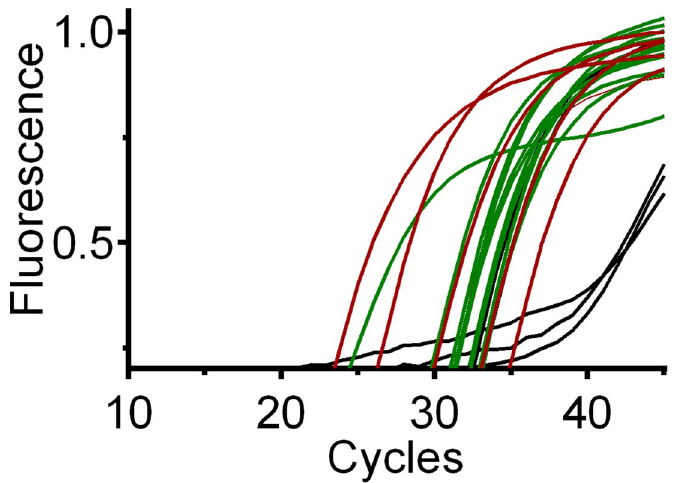
Figure 6. Human qPCR amplification of 14 samples (green), 5 serial dilutions (red) and NTC (no template control, black).